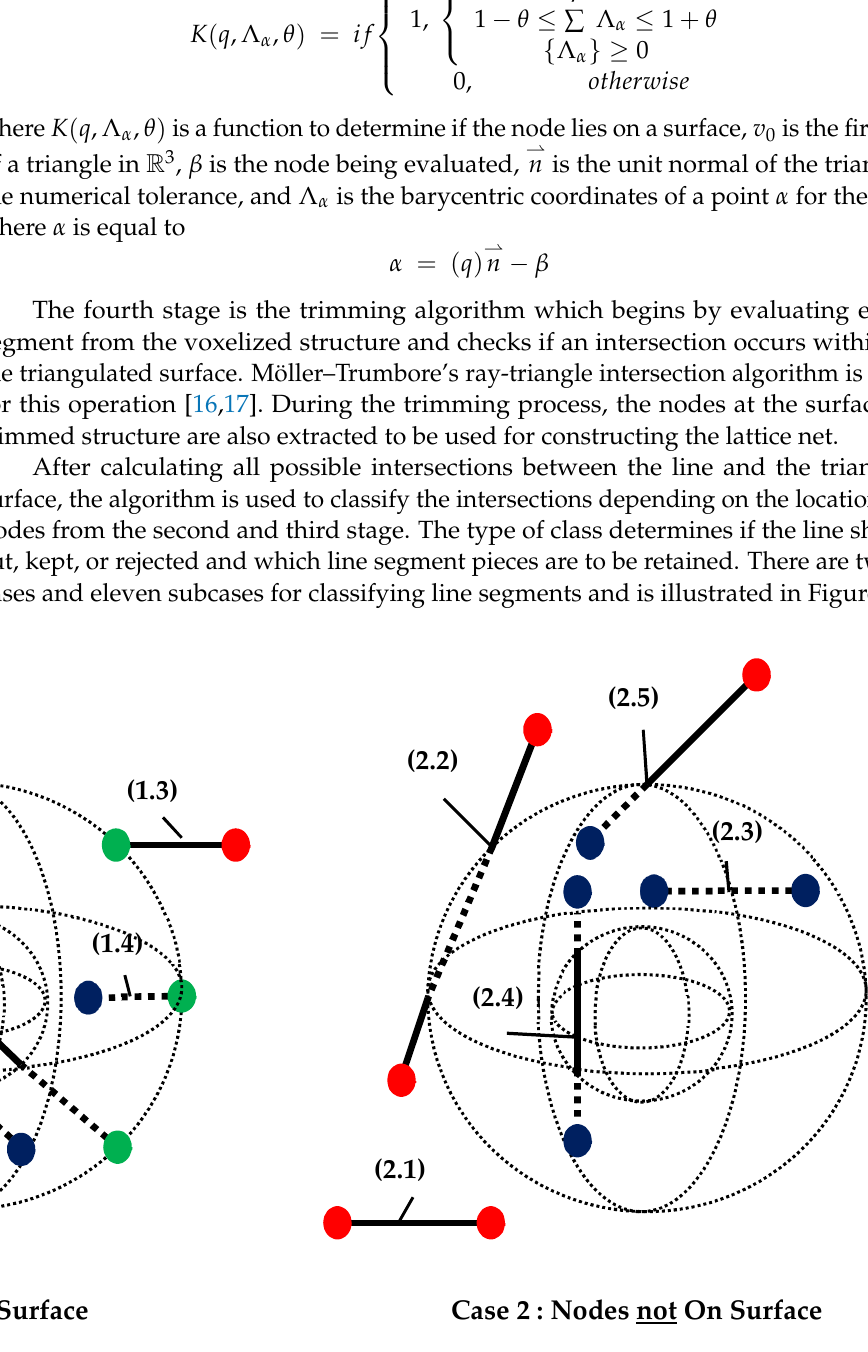
Figure 5. Line segment classification within a hollow sphere: (red) exterior node, (blue) interior node, (green) surface node, (dotted line) interior segment, and (solid line) exterior segment.